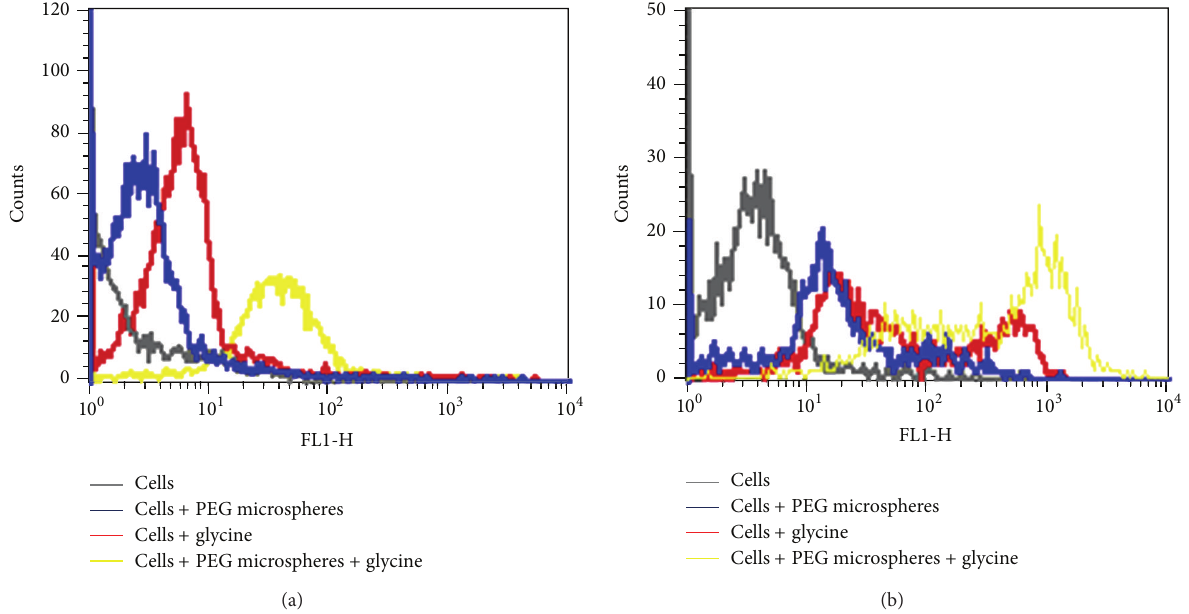
Table 3: Intracellular Ca 2+ release by mononuclear (MN) and polymorphonuclear (PMN) colostrum phagocytes in the presence of glycine adsorbed to PEG microsphere indicated by fluorescence intensity.